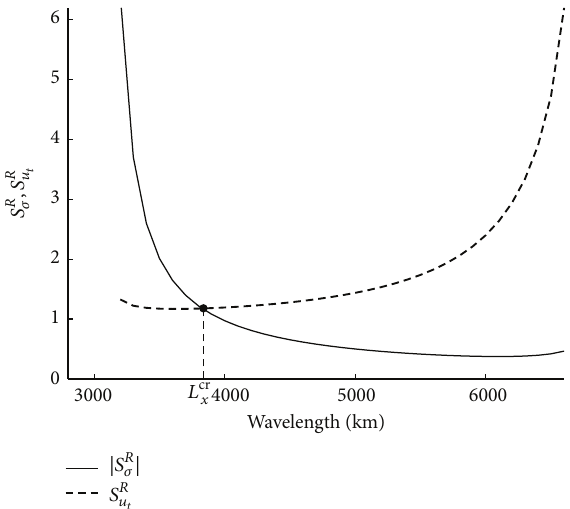
Figure 6: Relative sensitivity coefficients 𝑆 𝑅 𝜎 and 𝑆 𝑅 𝑢 wavelength 𝐿 𝑥 for the case of 𝜎 = 2 × 10 −6 m 2 ⋅ Pa −2 ⋅ s −2 and 𝑢 𝑇 = 7.5 m ⋅ s −1 .